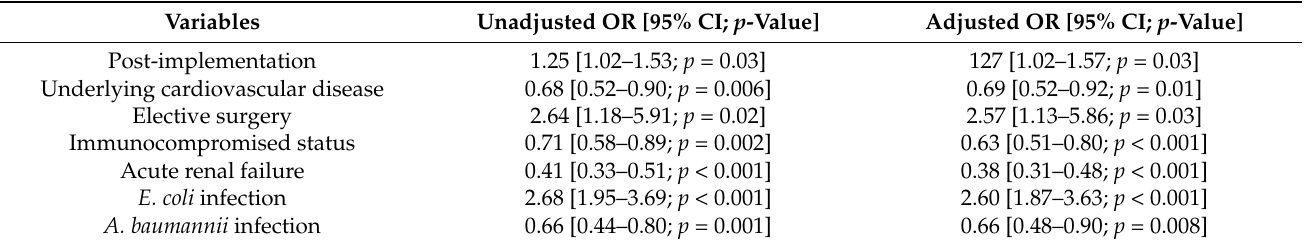
Table 4. Factors associated with favourable clinical response at the end of antibiotic therapy.